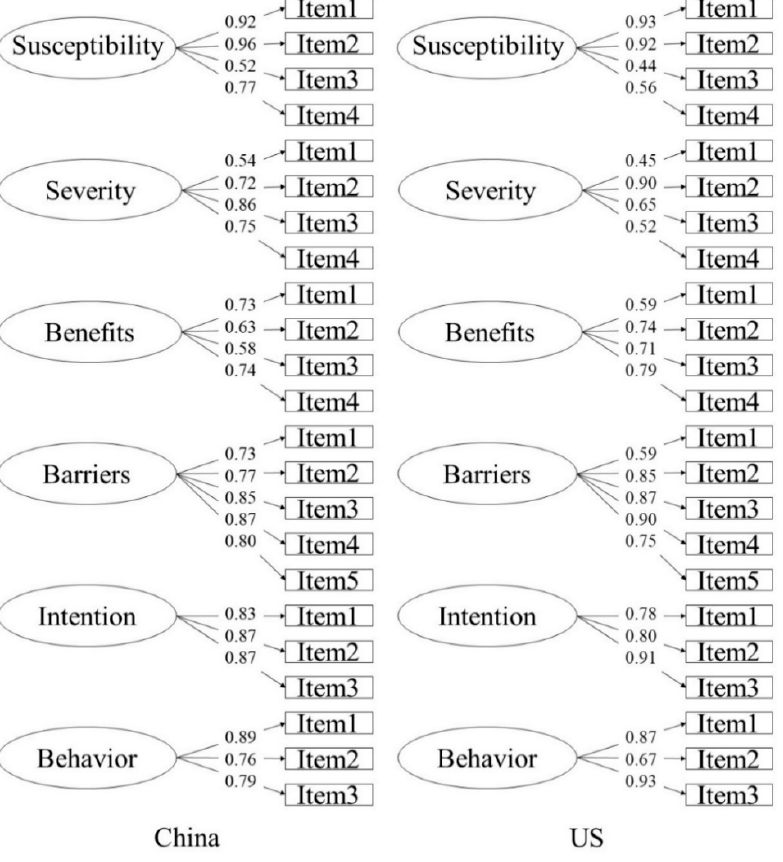
Figure 2. The confirmatory factor analysis (CFA) results of the measurement model in Chinese and US participants.